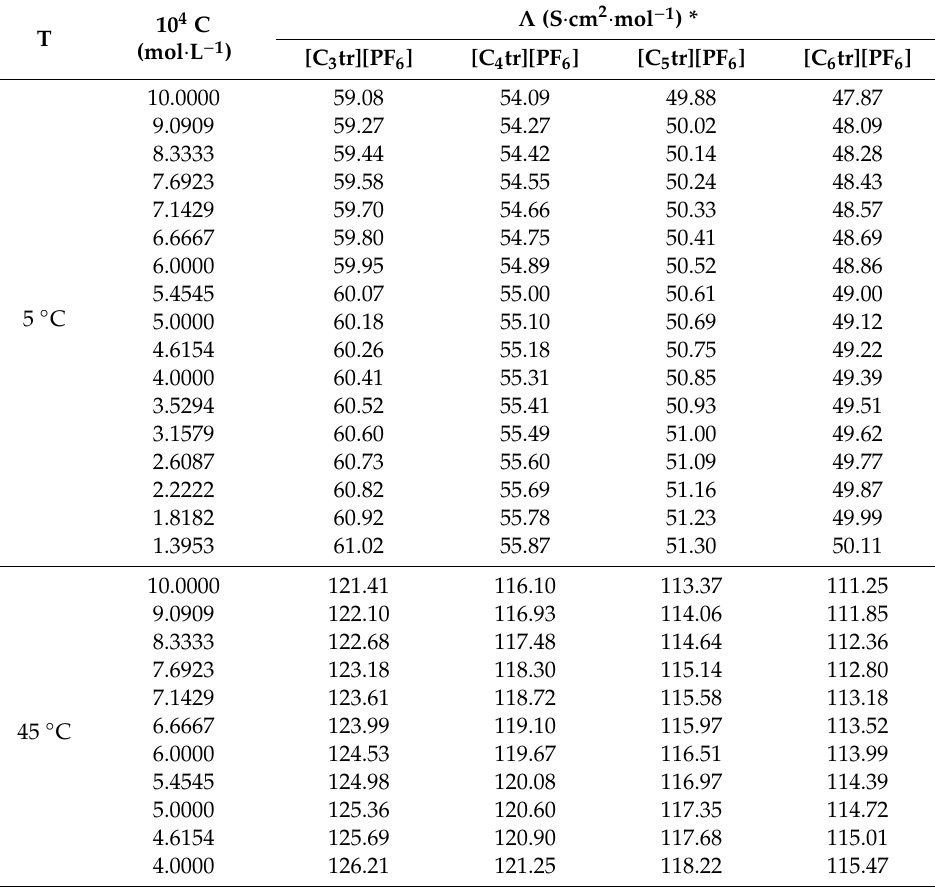
Table 2. The molar conductivities of seven tropine-type ionic liquids in aqueous solution.